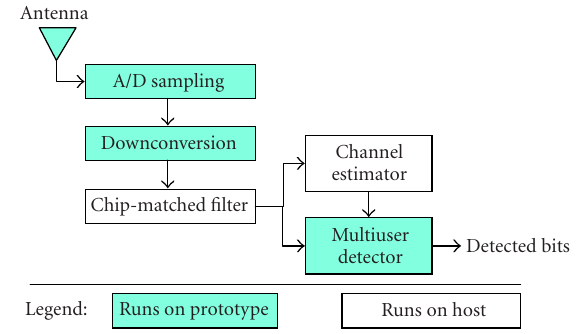
Figure 5: A CDMA baseband receiver, represented as a directed graph in which each node represents signal processing and each di- rected edge represents